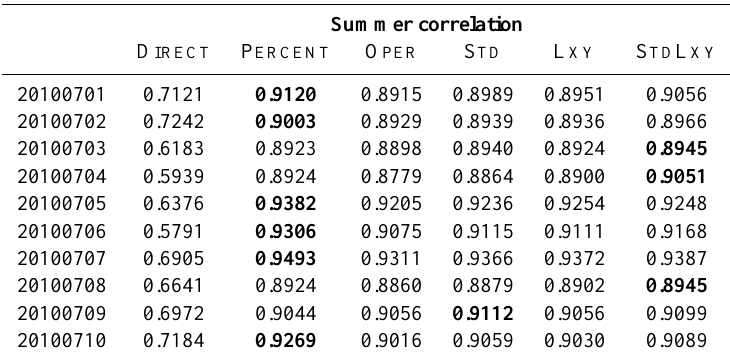
Table 3. Daily correlation between analysis of the experiments studied and assimilated observations, statistics during the period between 1 and 10 July 2010; the largest daily correlation is in bold.